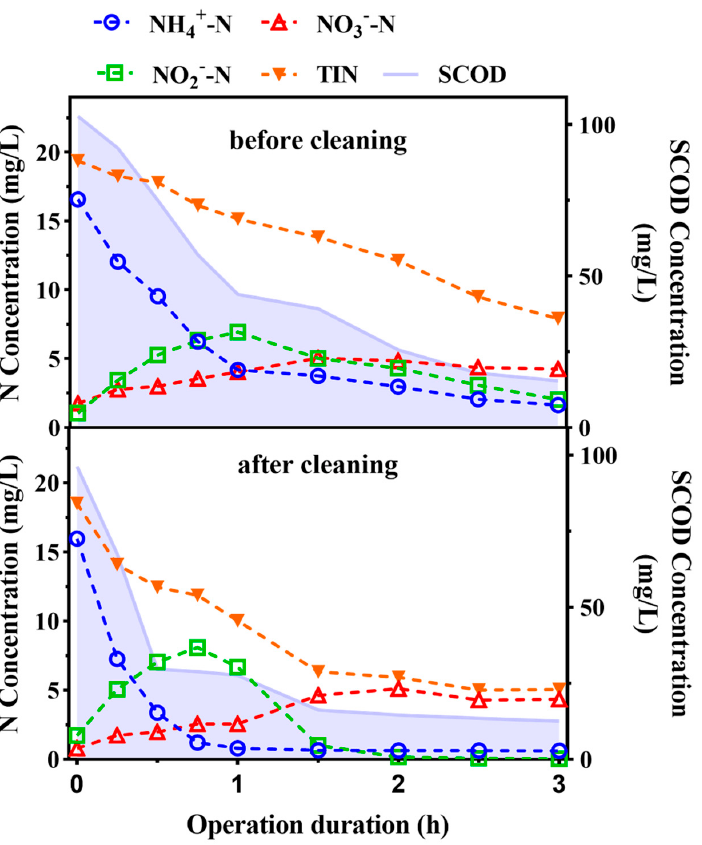
Figure 5. A typical cyclic test for degradation of SCOD and nitrogen before and after cycle cleaning process.